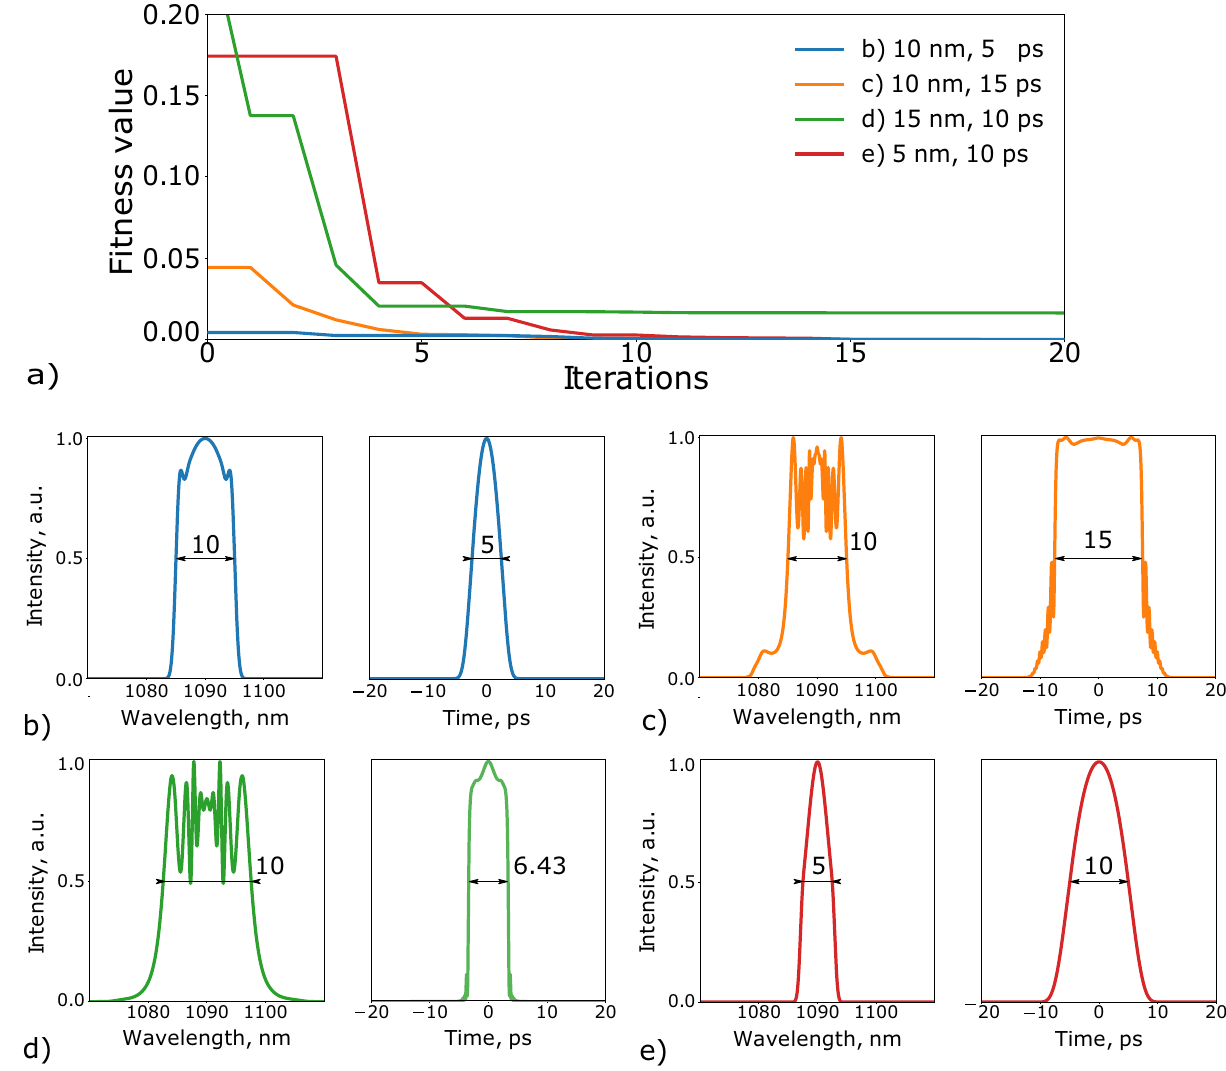
Figure 2. ( a ) Convergence of the fitness function for different target output pulse parameters. ( b – e ) Several examples of the spectral profile and temporal waveform of the dissipative solitons generated on